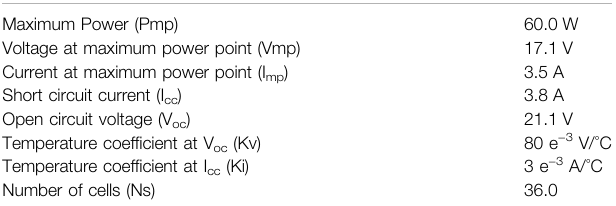
TABLE 3 | PV module speci fi cations at STC 1000 W/m 2 , 25 ° , AM1.5 (Dadjé et al., 2017a). Maximum Power (Pmp)